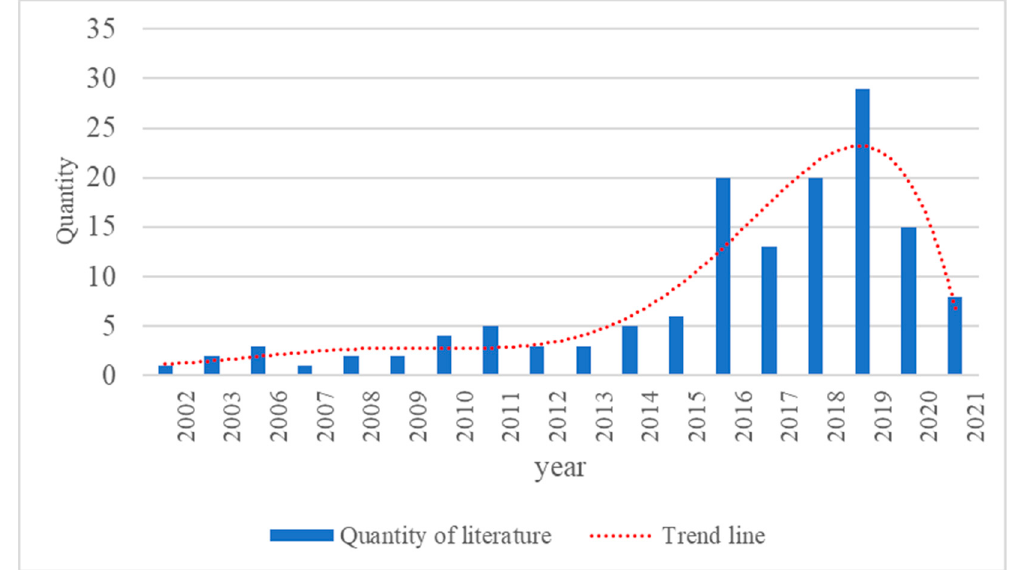
Figure 1. Quantitative distribution of the published literature in Vision Zero, 2002–2021.